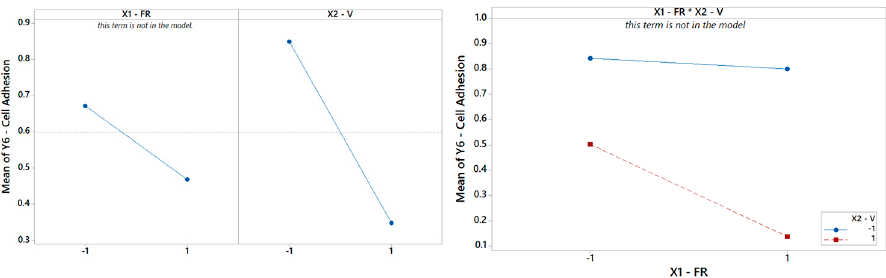
Figure 12. ( Left ) The main effects plot and ( right ) the interaction plot for cell adhesion.